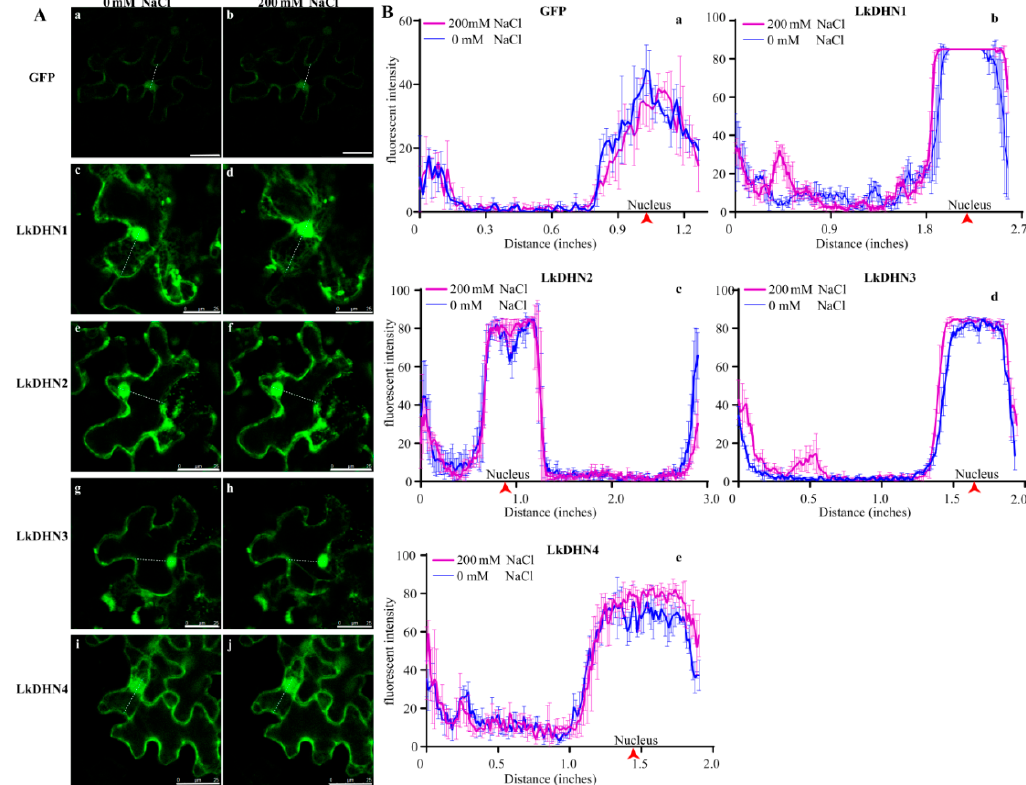
Figure 3. Stress treatment enhanced the signal of LkDHNs in nucleus. ( A ) The effect of salt stress on the nuclear localization of LkDHNs was observed by a Leica SP8 laser confocal microscope. a and b are GFP with 0 and 200 mM NaCl, respectively; c and d are LkDHN1 with 0 and 200 mM NaCl, respectively; e and f are LkDHN2 with 0 and 200 mM NaCl, respectively; g and h are LkDHN3 with 0 and 200 mM NaCl, respectively; i and j are LkDHN4 with 0 and 200 mM NaCl, respectively. ( B ) Analysis of GFP fluorescence signal in nucleus under salt stress. a : GFP; b : LkDHN1; c : LkDHN2; d : LkDHN3; e : LkDHN4. The purple line represents the fluorescence after 30 min treatment with 200 mM NaCl, and the blue line represents the fluorescence under 0 mM NaCl. The nucleuses were indicated by red arrow.